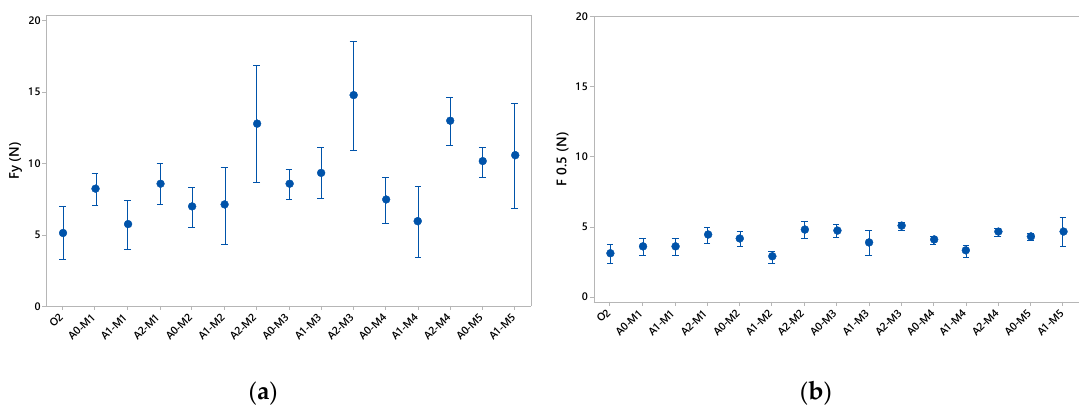
Figure 17. ( a ) Compression forces at stress yield; ( b ) Compression forces for a displacement of 0.5 mm.